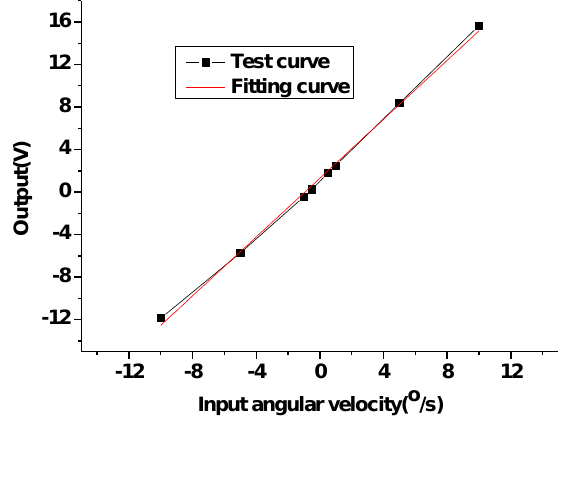
Figure 17. The closed-loop scale factor test of the second generation with a small installation